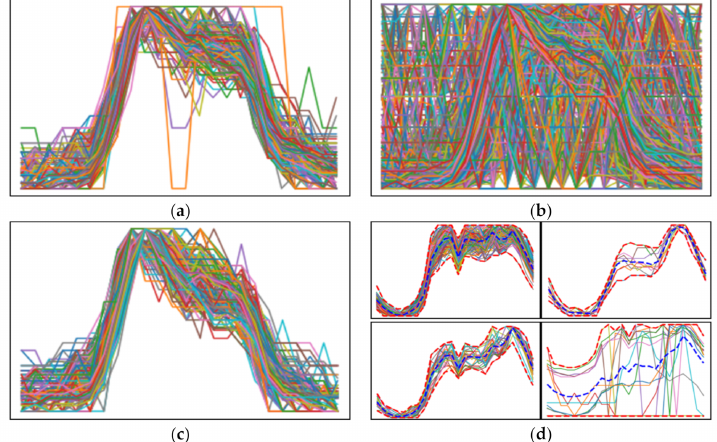
Figure 3. Examples of clustering results using well-known methods: ( a ) K-Means; ( b ) DBSCAN; ( c ) GMM; ( d ) the result of the clustering with a specific DL using